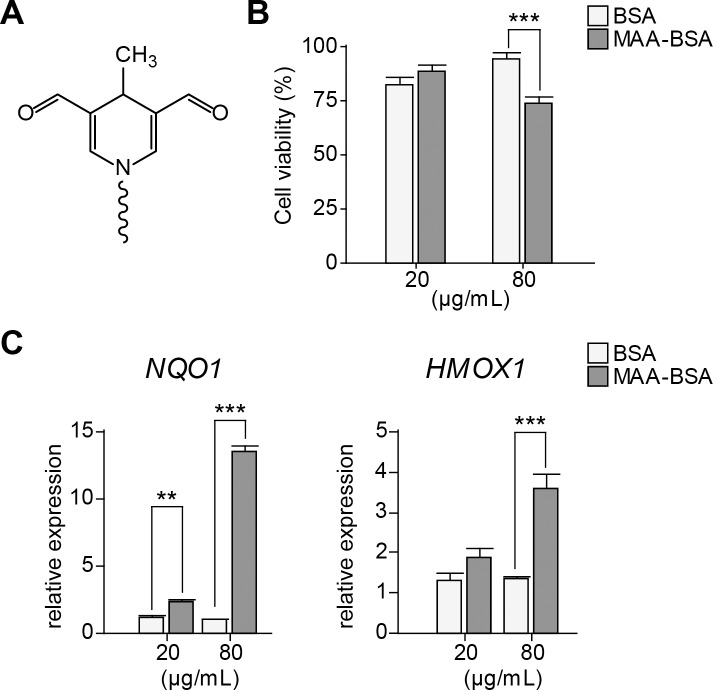
Cell survival and alteration of the stress response under MAA-BSA treatment in WERI-Rb1 cells.(A) Schematic structure of MDHDC (4-methyl-1,4-dihydropyridine-3,5-dicarbaldehyde), the most prominent adduct in malondialdehyde-acetaldehyde (MAA) protein modifications. (B-C) Cells treated with 20 or 80 μg/mL of BSA or MAA-BSA for 24 h. (B) Cell viability (%) measured by MTT assay; the repetition with the highest value was considered as 100% (each value corresponds to the mean ± SEM of six-fold independently performed replicates). (C) Gene expression of NAD(P)H dehydrogenase [quinone] 1 (NQO1) and Heme oxygenase 1 (HMOX1) (each value corresponds to the mean ± SEM of three-fold independently performed replicates). Statistics: 2-way ANOVA and simple effect test (when significant interaction). ***p<0.001, **p<0.01.